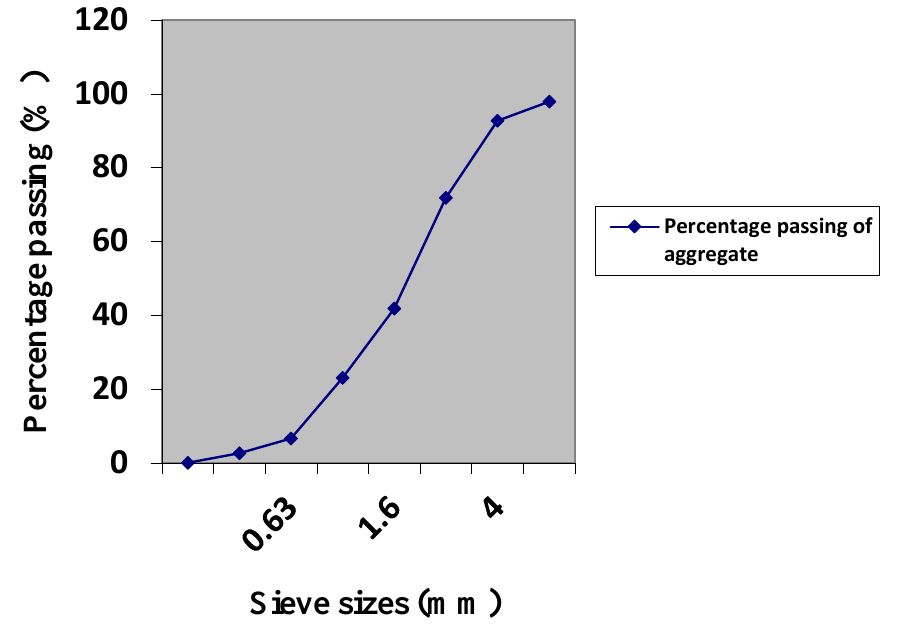
Fig. 1. Sieve analysis graph for fine aggregate.